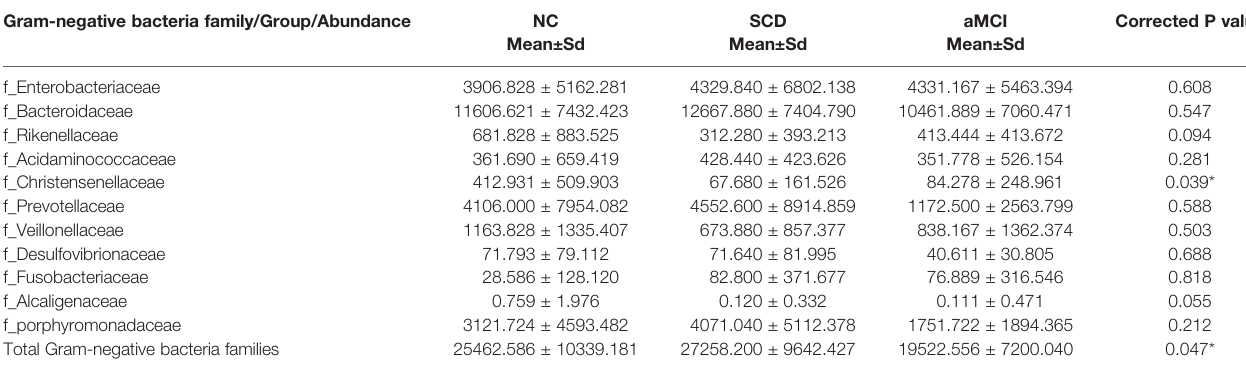
TABLE 3 | Abundance of Gram-negative bacteria families between different cognitive